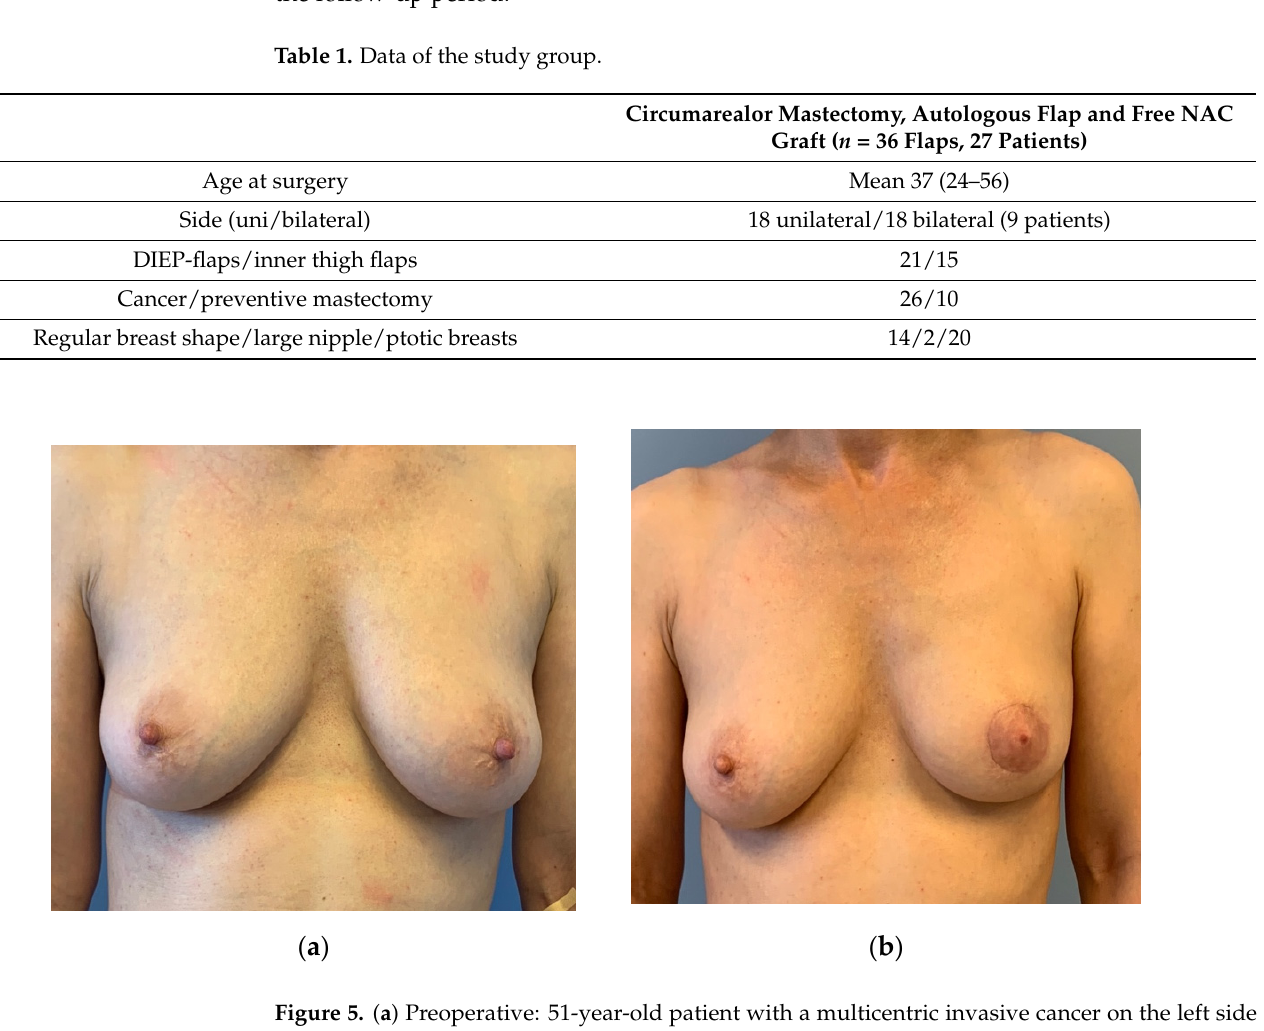
Table 2. Results after mastectomy, autologous breast reconstruction and free NAC grafting.